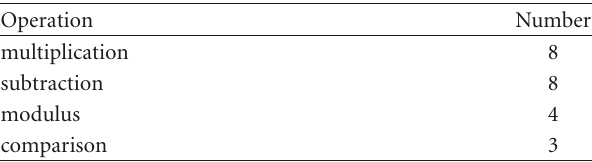
Figure 10: BEP for I × J -QAM subject to Rayleigh fading ( m = 1) and di ff erent values of I and J . Table 1: Number of real operations required by detector DI to obtain the estimate - s ( t ) of the transmitted symbol s ( t ) based on the noisy observation r ( t ) considering M =